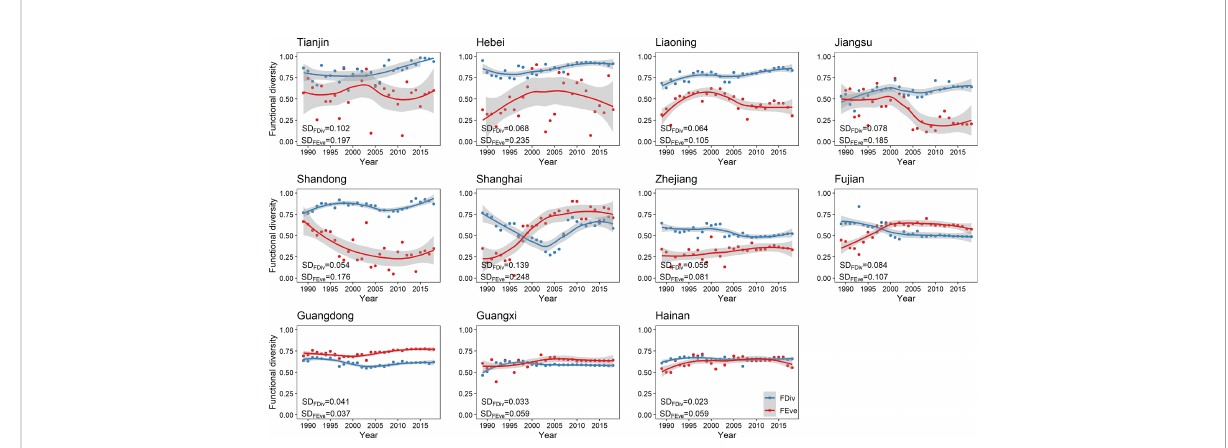
FIGURE 1 Locally estimated scatterplot smoothing regression curves of functional diversity for each coastal province from 1989 to 2018. The shaded gray column indicates 95% con fi dence interval. SD FEve , standard deviation of functional evenness; SD FDiv , standard deviation of functional divergence. (FEve, functional evenness; FDiv, functional